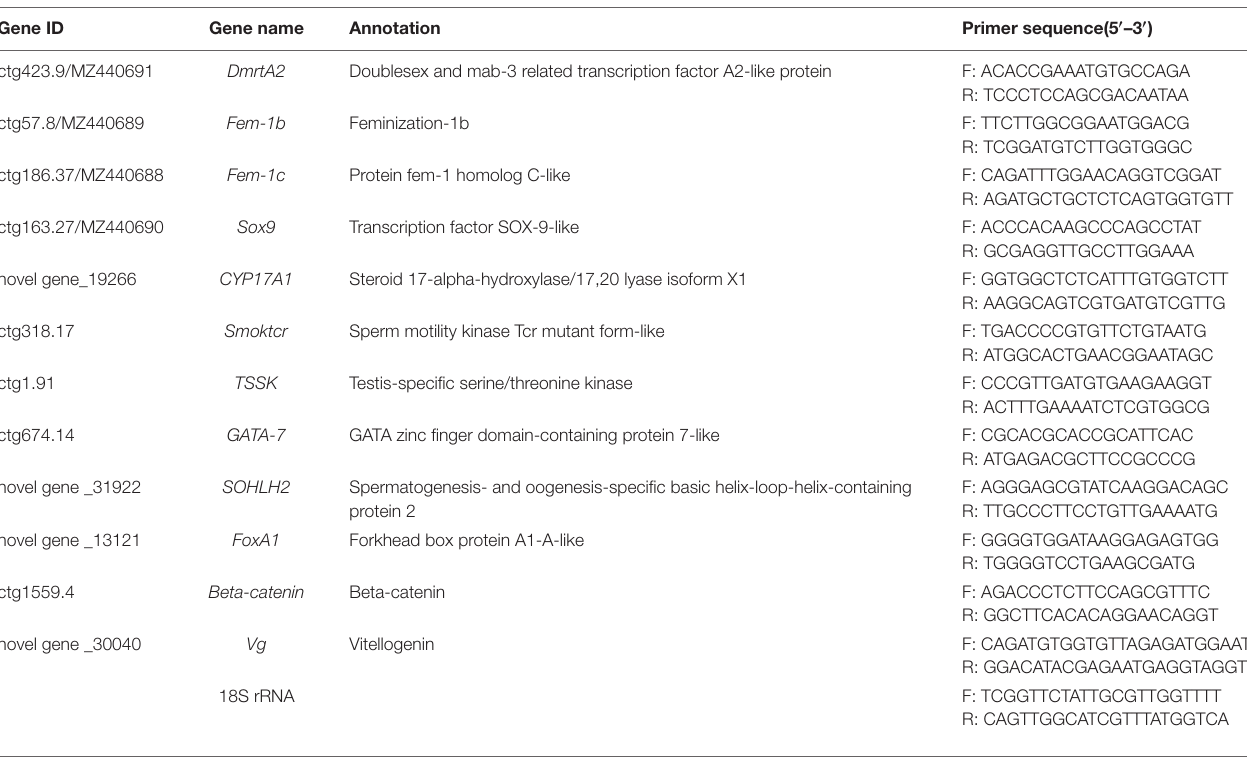
TABLE 1 | The information of genes validated by qRT-PCR.